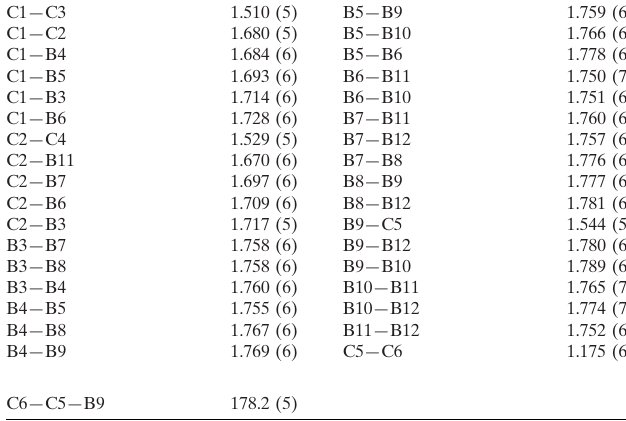
Selected geometric parameters (A˚ , (cid:4)